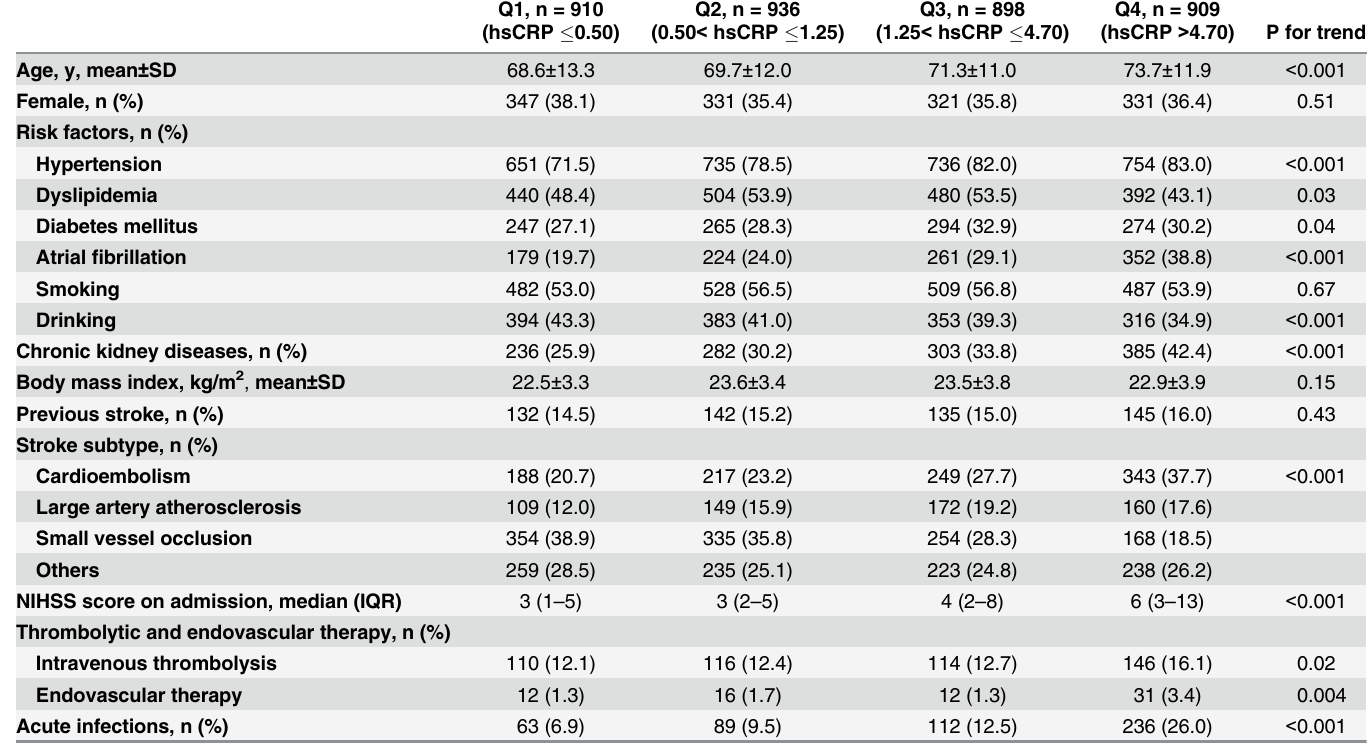
Table 1. Characteristics of patients.